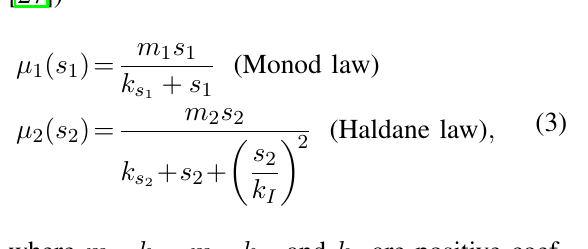
D EFINITION OF THE MODEL PHASE VARIABLES AND PARAMETERS s 1 concentration of chemical oxygen demand (COD) [ g/l ] s 2 concentration of volatile fatty acids (VFA) [ mmol/l ] x 1 concentration of acidogenic bacteria [ g/l ] x 2 concentration of methanogenic bacteria [ g/l ] u dilution rate [ day − 1 ] s i 1 influent concentration s 1 [ g/l ] s i 2 influent concentration s 2 [ mmol/l ] k 1 yield coefficient for COD degradation [ g COD/(g x 1 )] k 2 yield coefficient for VFA production [ mmol VFA/(g x 1 )] k 3 yield coefficient for VFA consumption [ mmol VFA/(g x 2 )] k 4 coefficient [ l 2 /g ] Q methane gas flow rate m 1 maximum acidogenic biomass growth rate [ day − 1 ] m 2 maximum methanogenic biomass growth rate [ day − 1 ] k s saturation parameter associated with s 1 [ g COD/l ] 1 k s saturation parameter associated with s 2 [ mmol VFA/l ] 2 k I inhibition constant associated with s 2 [ (mmol VFA/l) 1 / 2